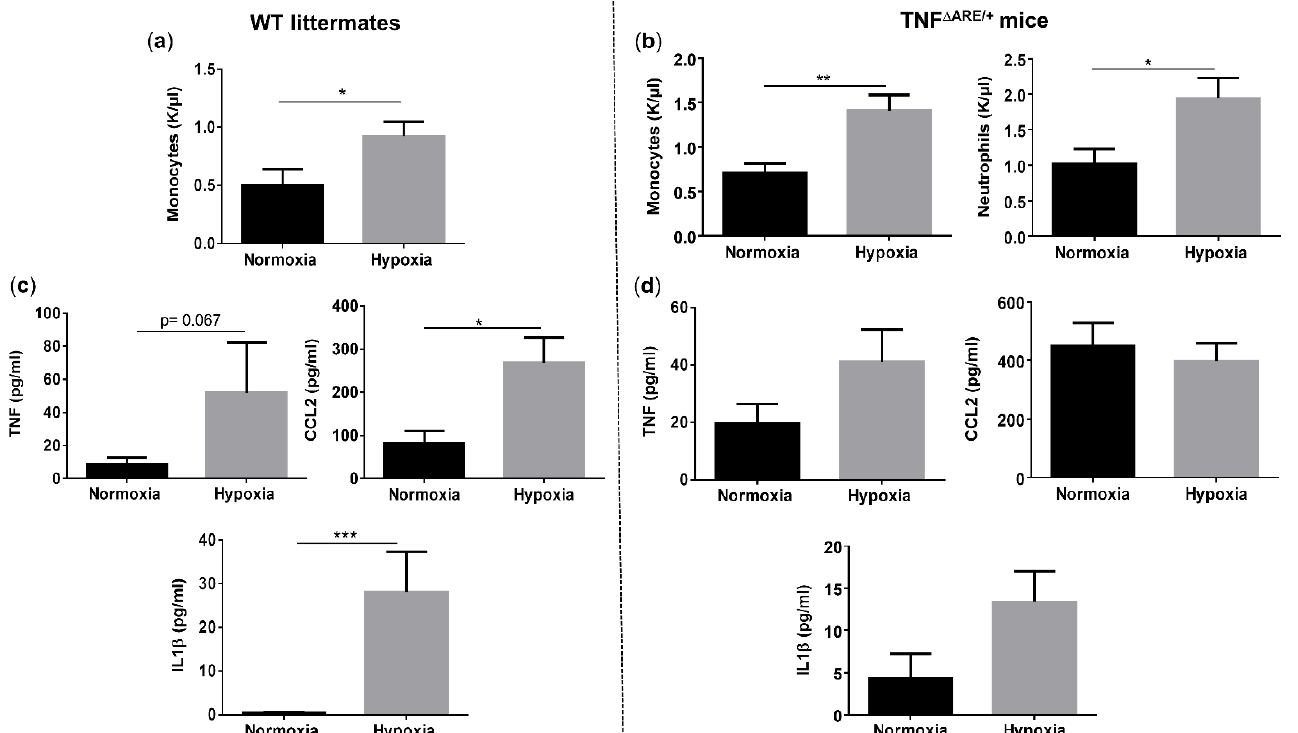
Figure 3. Long-term environmental hypoxia exposure in WT mice induces systemic inflammation. ( a ) Circulatory monocytes were increased in WT mice housed in hypoxia. ( b ) In TNF ∆ ARE/+ mice housed in hypoxia, circulatory monocytes and neutrophils are increased in comparison to TNF ∆ ARE/+ mice housed in normoxia. Serum levels of TNF, CCL2 and IL1 β in ( c ) WT littermates housed in normoxia and hypoxia and ( d ) TNF ∆ ARE/+ mice housed in normoxia and hypoxia. * p < 0.05, ** p < 0.01, *** p < 0.001. Data are represented as the mean ± SEM.